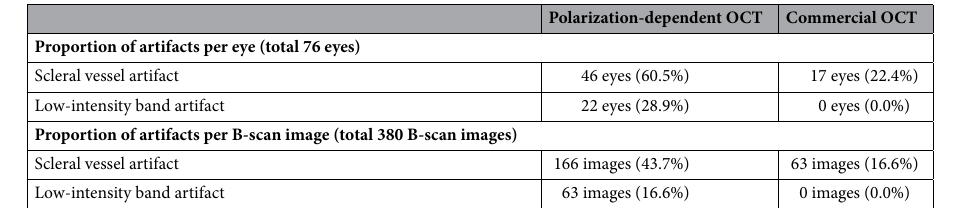
Table 1. Proportion of birefringence-derived artifacts in OCT B-scan images of the sclera. OCT, optical coherence